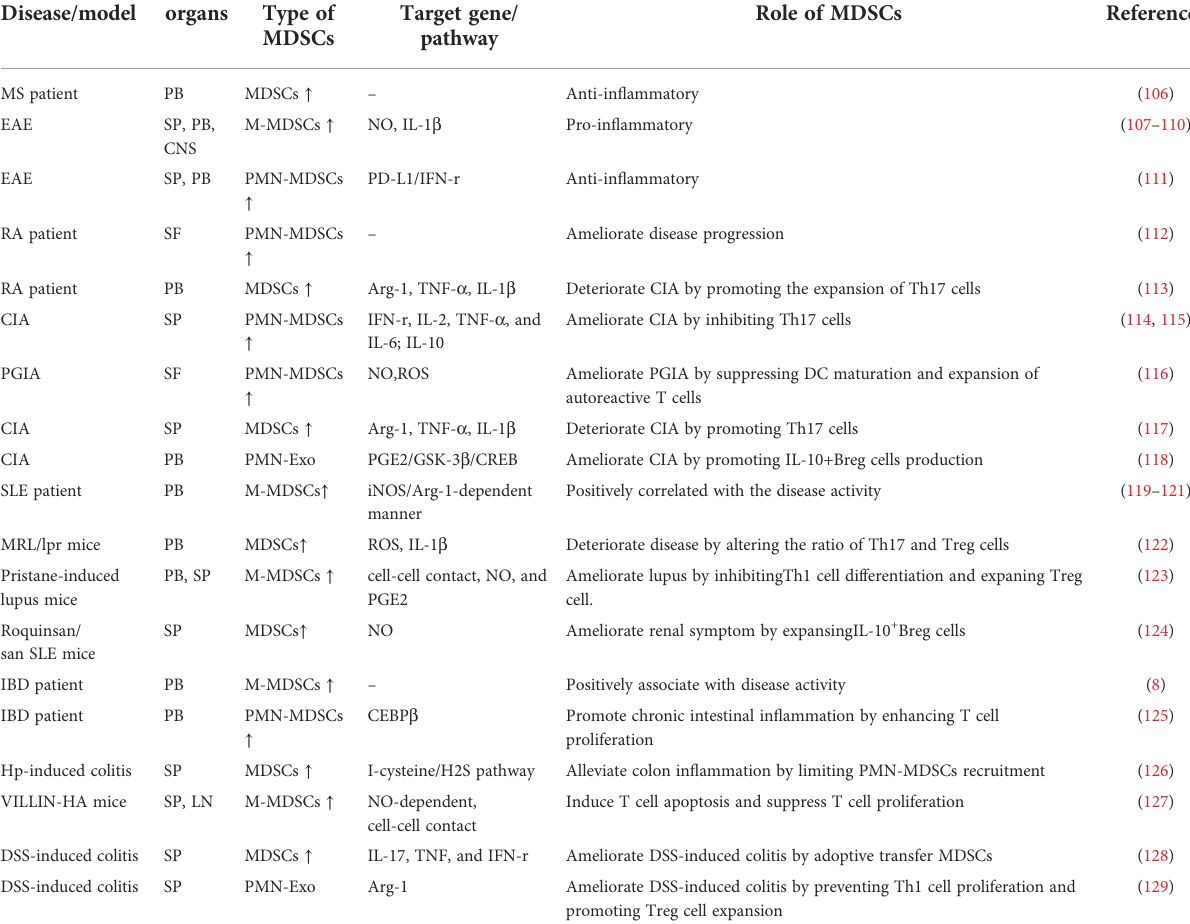
TABLE 3 The potential role of MDSCs in different autoimmune diseases.